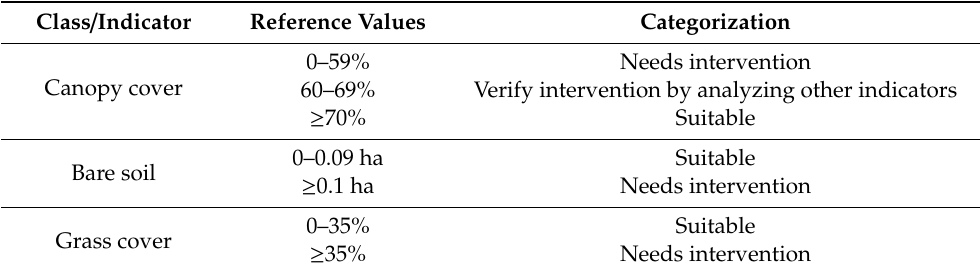
Table 1. Selected land cover indicators for restoration monitoring with UAV and LiDAR, and categorization defined according to reference values for each